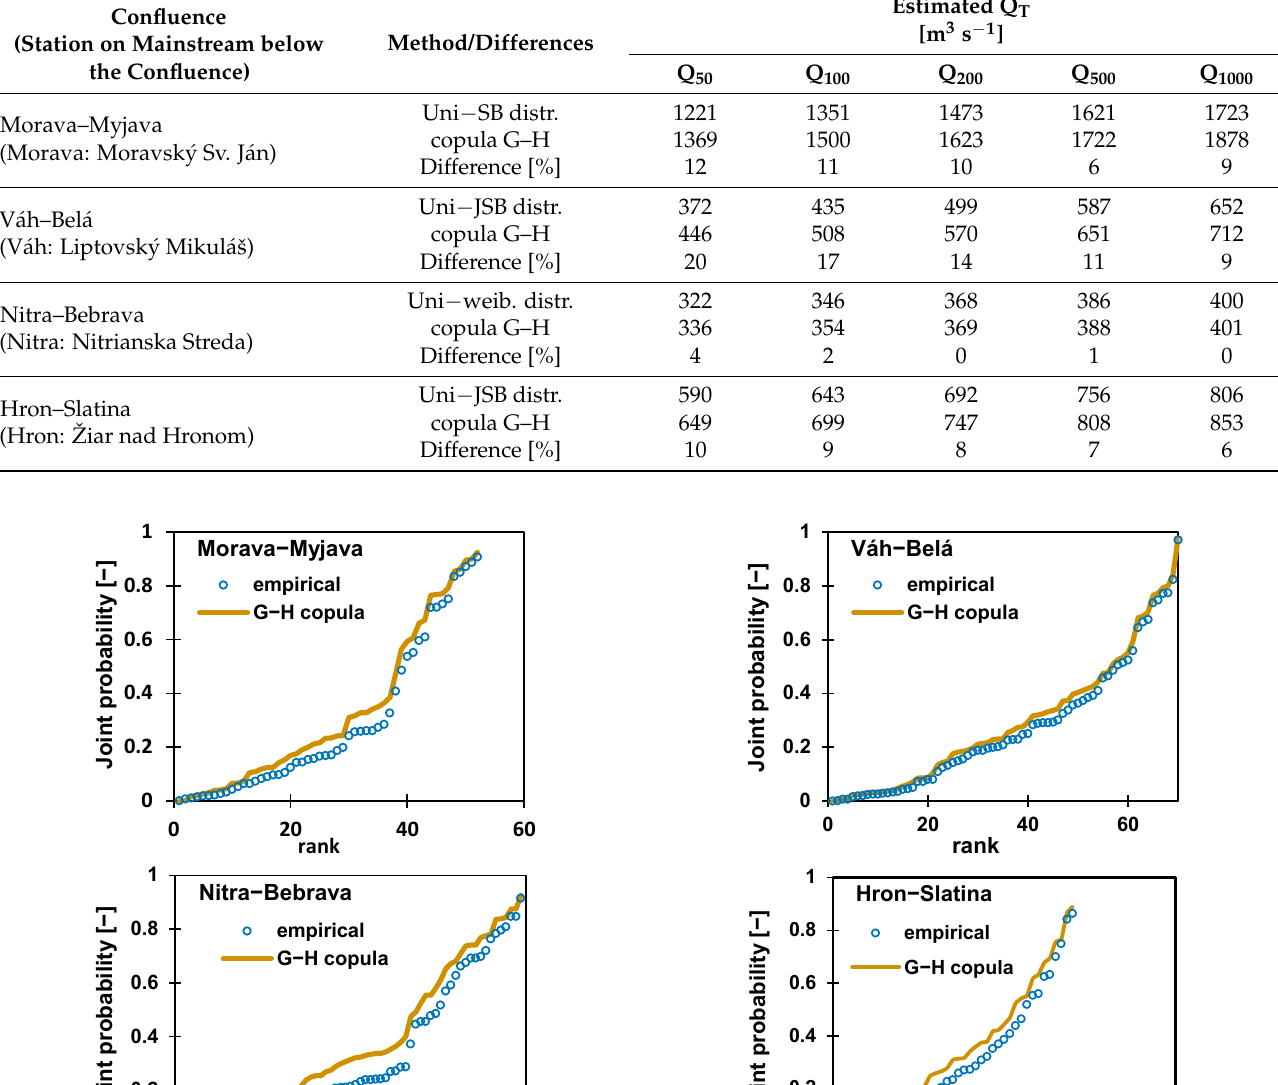
Table 5. Comparison of design discharges (Q 50 , Q 100 , Q 500 , Q 1000 ) based on univariate (Uni.) and based on the copula method at the mainstream stations below the confluences Q maxdwn .